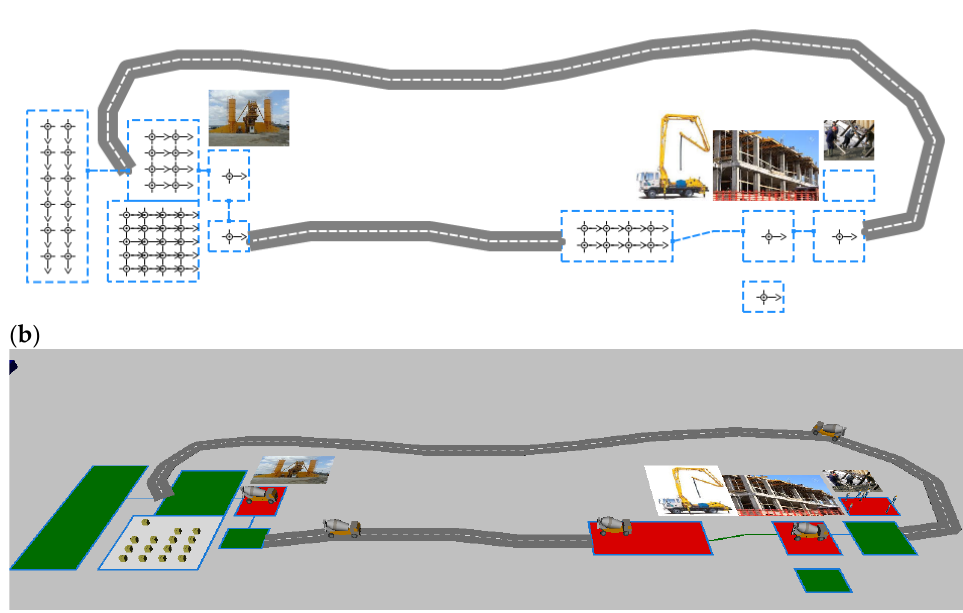
Figure 4. Representations of the simulation model: ( a ) 2D; ( b ) 3D. It is possible to view the changes of various states, quantities, and parameters during the simulation from a number of diagrams, histograms, and variables (Figure 5).